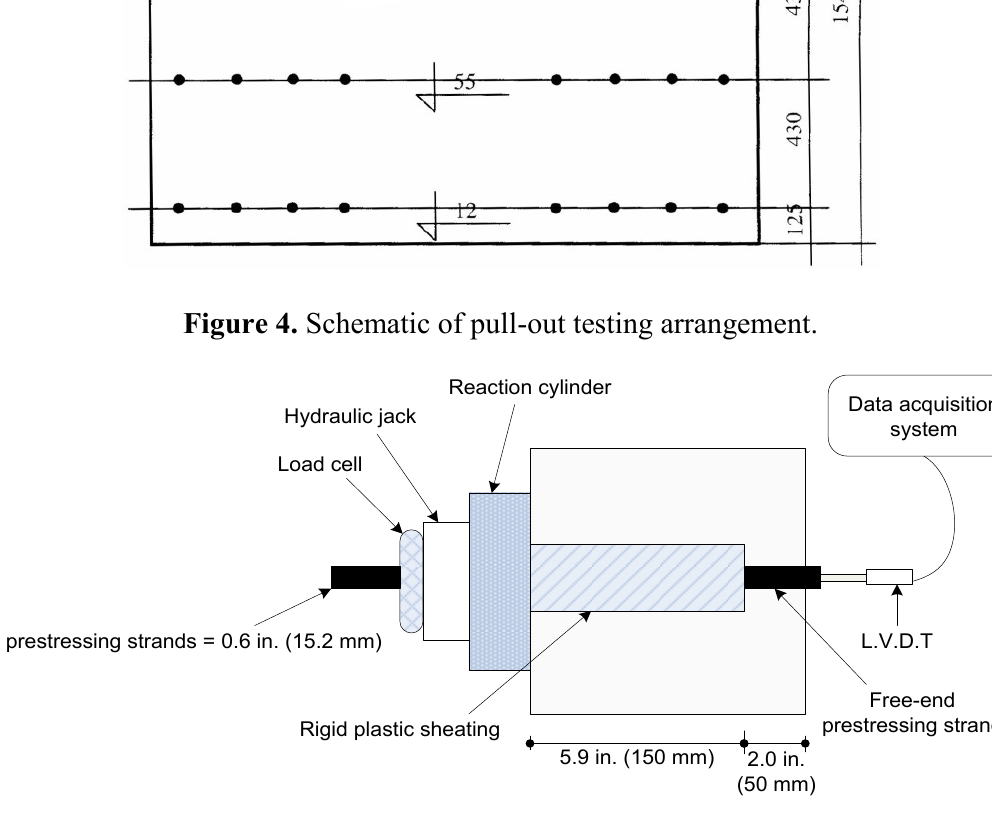
Figure 5. Monitoring of free-end slip of prestressing